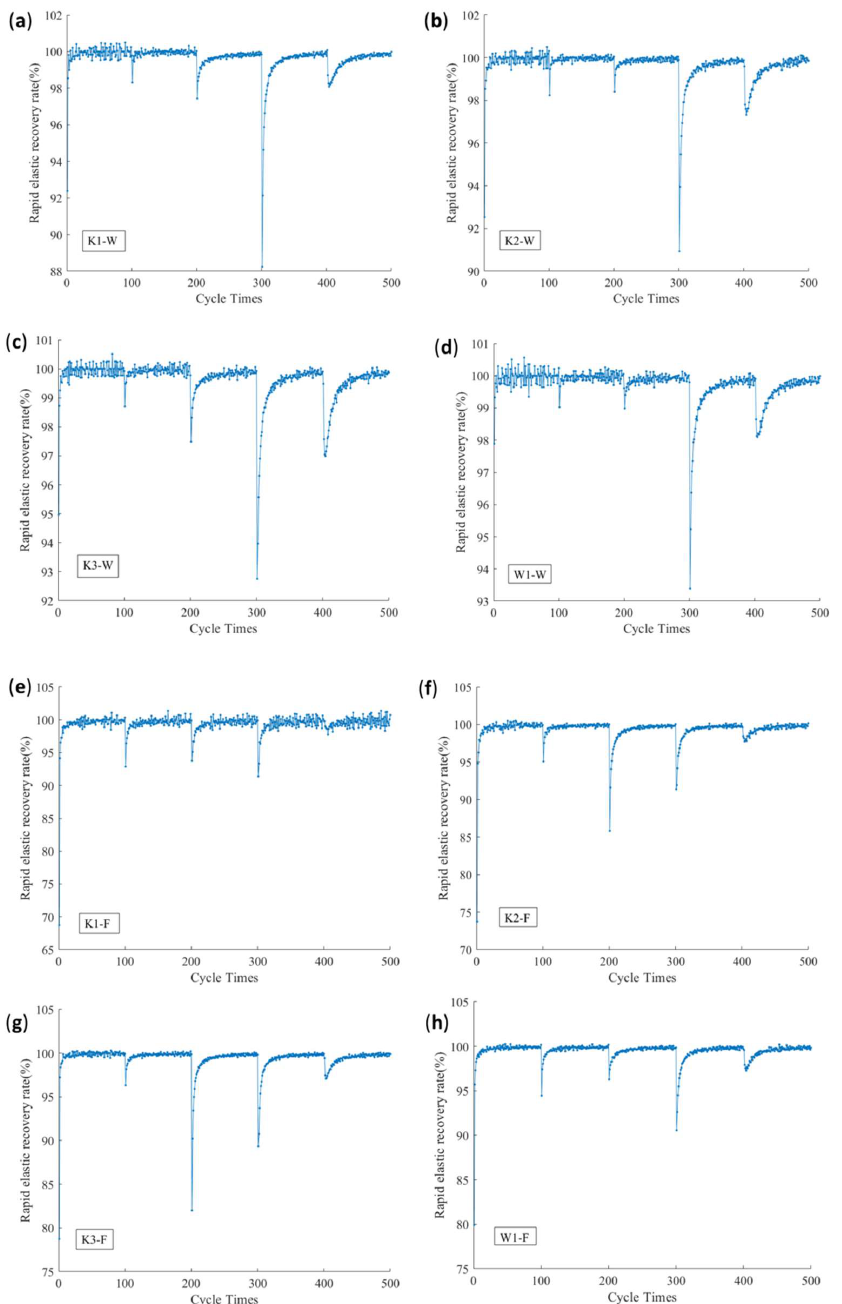
Figure 7. Variation curves of the rapid elastic recovery rate with stress. ( a – d ) Rapid elastic recovery rate of the warp direction of K 1 , K 2 , K 3 , and W 1 . ( e – h ) Rapid elastic recovery rate of the fill direction of K 1 , K 2 , K 3 , and W 1 .